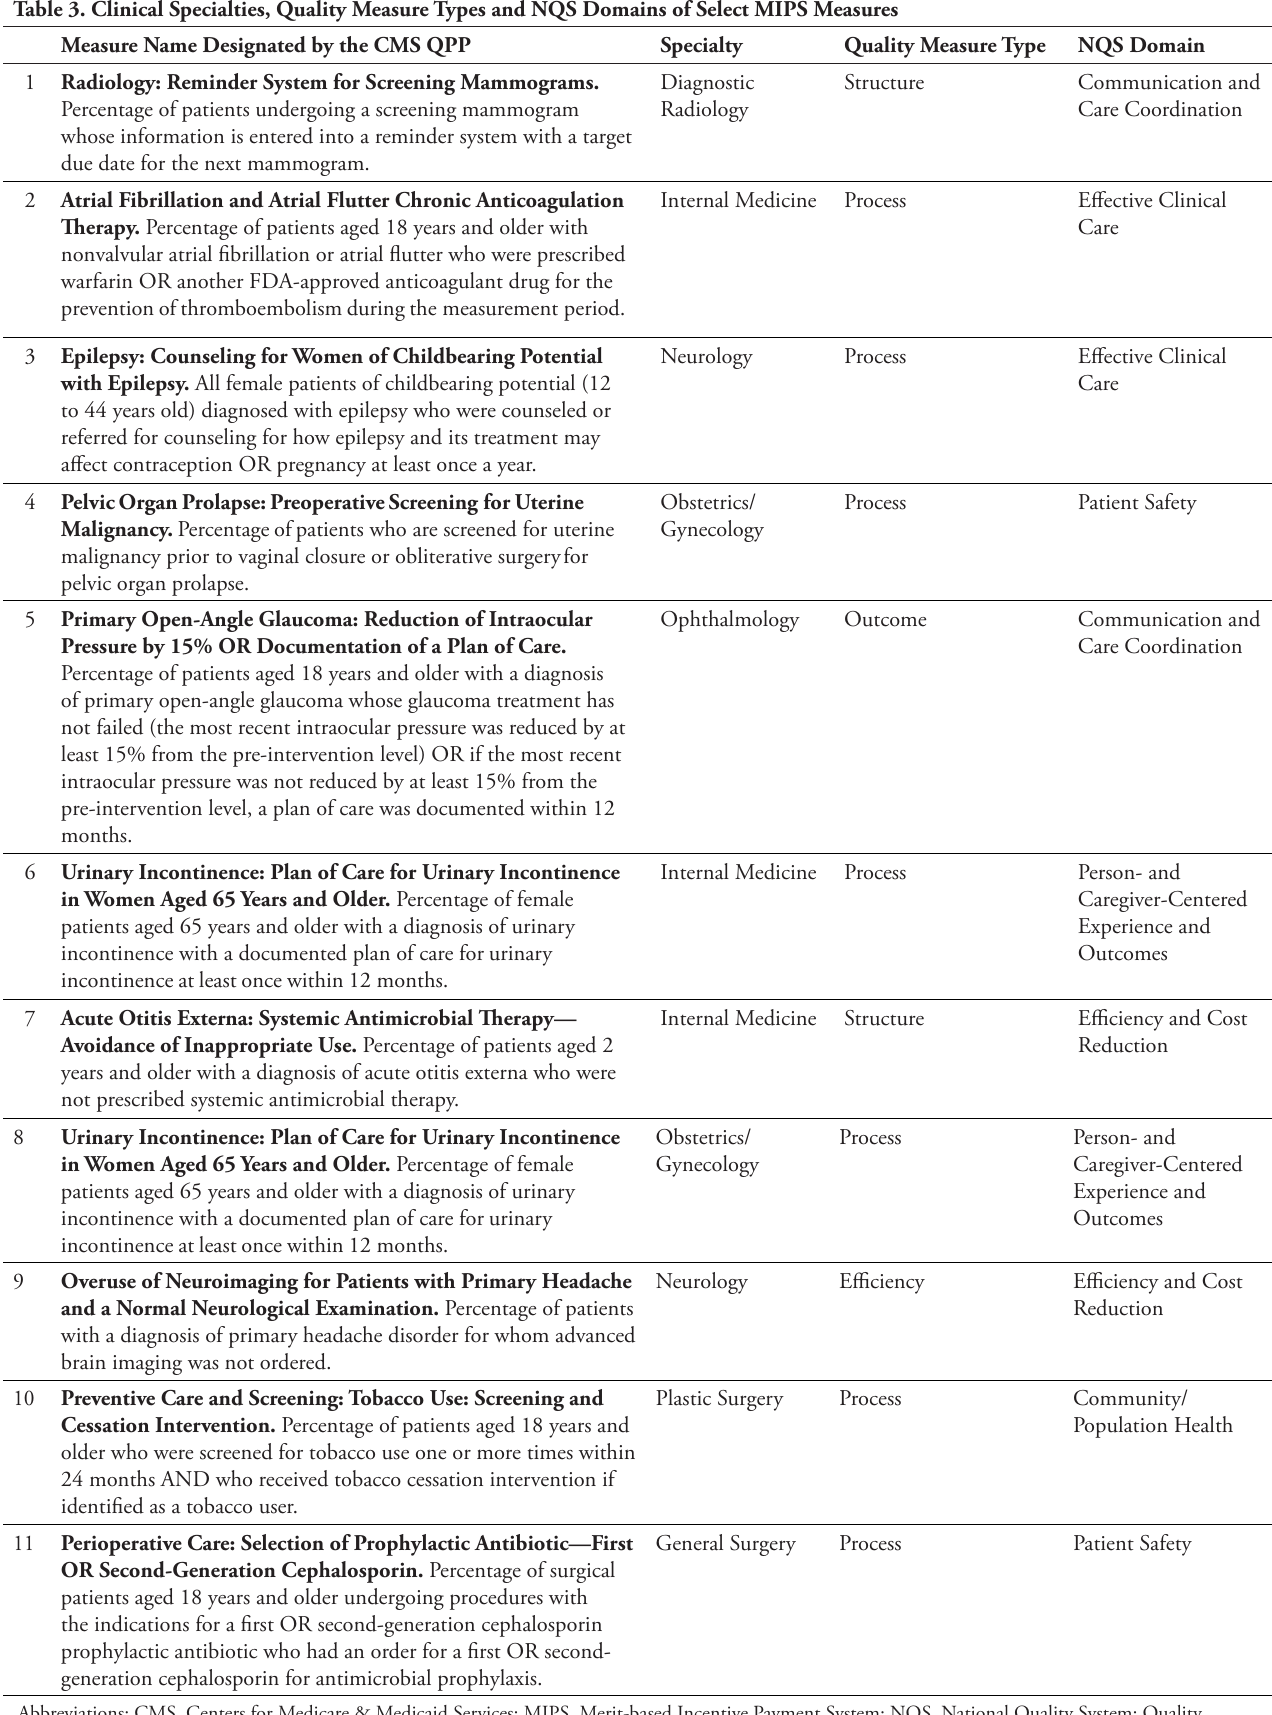
Table 3. Clinical Specialties, Quality Measure Types and NQS Domains of Select MIPS Measures Measure Name Designated by the CMS